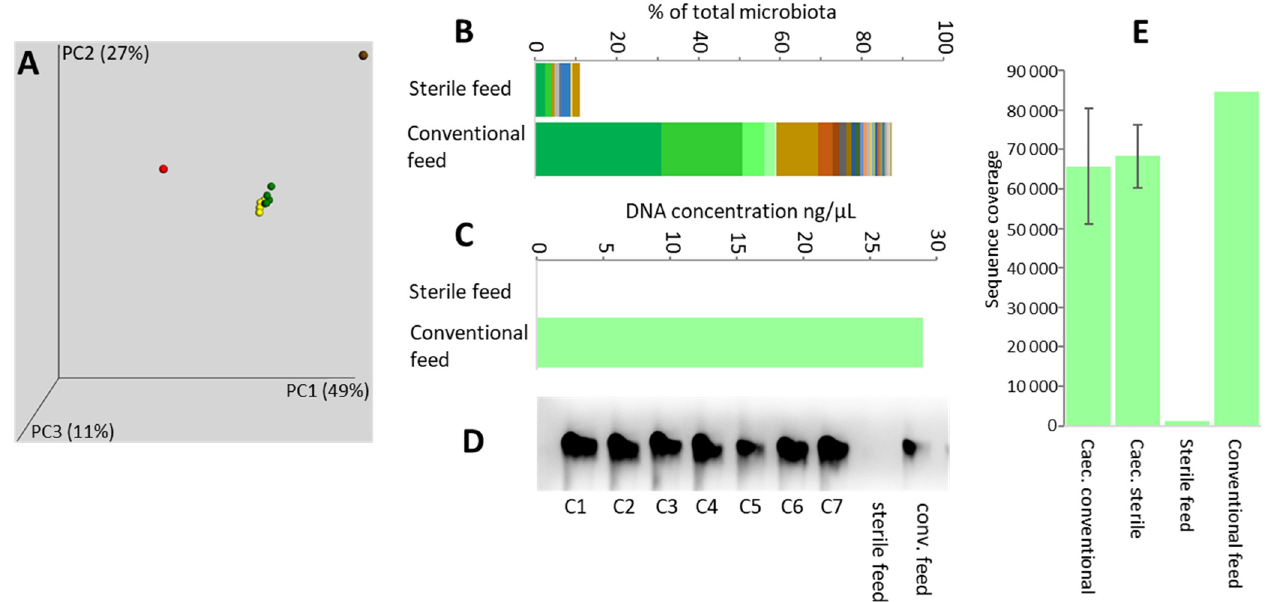
Figure 3. Feed as a source of chicken gut microbiota. ( A ), weighted PCoA analysis of microbiota in conventional (brown dot) and sterile feed (red dot) differed from the caecal microbiota of one-week-old chickens fed with conventional (green dots) or sterile feed (yellow dots). Conventional feed microbiome was dominated by chloroplast rRNA sequences from plants used for feed manufacturing. Top 30 OTUs from conventional feed showed in ( B ) formed 87.3% of all reads, and chloroplast assigned reads (shown in shades of green) formed 59.1% of all reads (see Table S2 for taxa composition). DNA in feed samples was degraded by autoclaving and low DNA concentration ( C ), low quality of PCR products (( D ), c1–c7 stands for 7 caecal samples, followed by amplification products obtained using DNA from sterile or conventional feed as template) and low number of sequences ( E ) were obtained for the sterile feed sample.